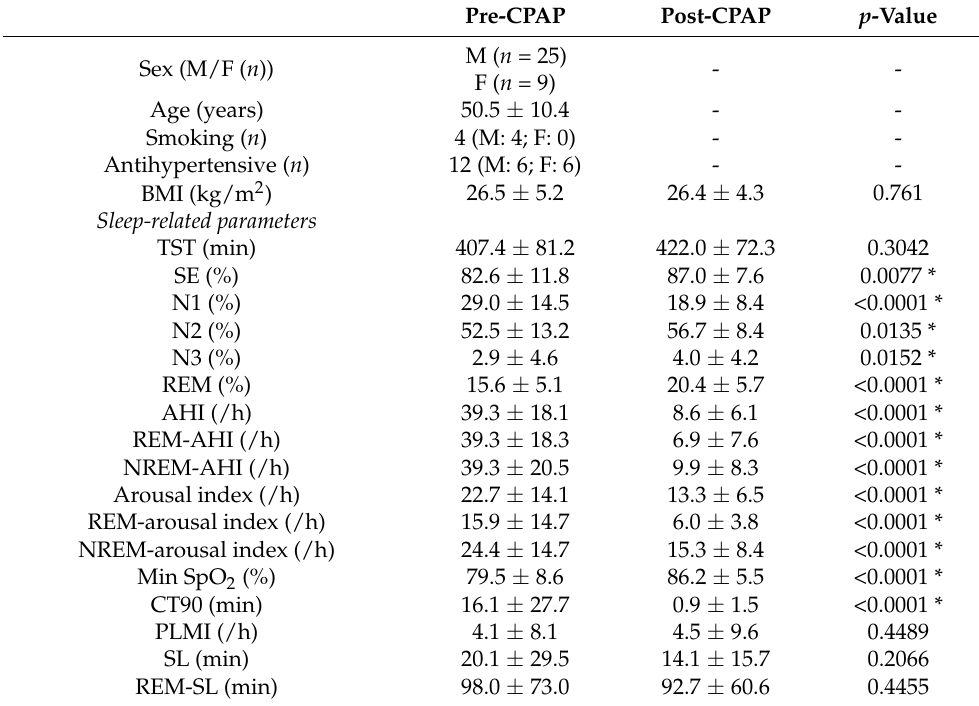
Table 1. Patient demographics and